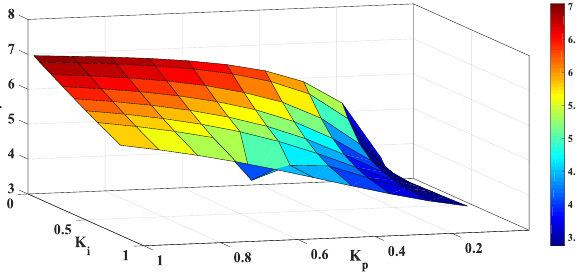
= 0.01. Figure 6. Maximum permitted delay for an EV aggregator with 1